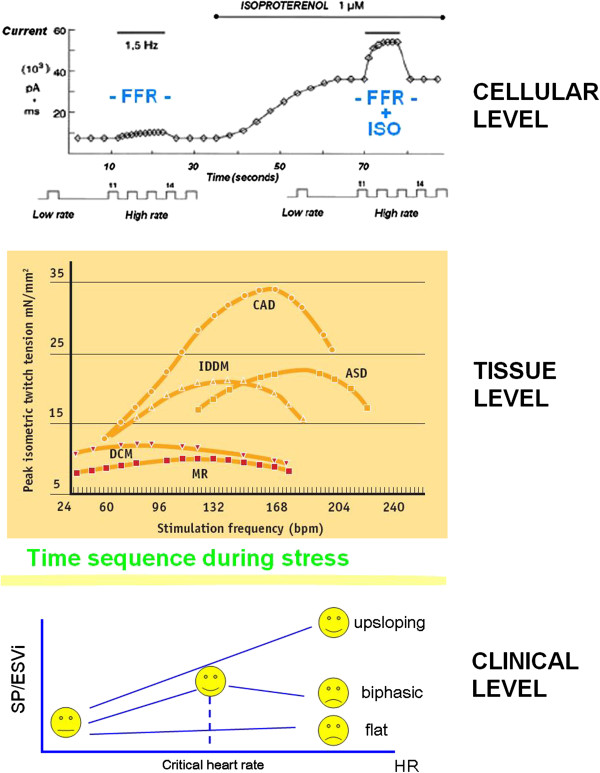
FFR, from myocardial strips to the echo lab. Isolated cardiomyocytes (upper panel): upregulation of Ca2+ entry through Ca2+ channels by high rates of beating is involved in the frequency-dependent regulation of contractility. The effect of increasing contractility by increasing heart rate ("pure" Bowditch treppe) is intrinsic to myocardium and takes a few seconds to occur, while the β-adrenergic amplification of the force-frequency relation (FFR) takes longer, i.e., 30–40 seconds, the time it takes for β-receptor activation and cAMP synthesis (on the right: FFR + ISO). (Modified from: Piot C, Circ 1996 [3]). Middle panel: measurements of twitch tension in isolated left-ventricular strips from explanted cardiomyopathic hearts: the FFR of these failing groups both exhibit a negative treppe at contraction frequencies above about 100 bpm. The contraction frequency at which the FFR begins its descending limb ("optimum stimulation frequency") declines progressively in the order: ASD (atrial septal defect), CAD (coronary artery disease), IDDM (diabetic myopathy), MR (mitral regurgitation), DCM (dilated cardiomyopathy). (Modified from: Mulieri LA. R.A. Howarth Ed. 1997). Lower panel: time sequence during stress echo; the force-frequency relation is built off line. The force-frequency relation is defined as up-sloping when the peak stress systolic pressure/end-systolic volume index (SP/ESV index) is higher than baseline and intermediate stress values; biphasic, with an initial up-sloping followed by a later down-sloping trend, when the peak stress SP/ESV index is lower than intermediate stress values; flat or negative, when the peak stress SP/ESV index is equal to or lower than baseline stress values. The critical heart rate (or optimum stimulation frequency) is the human counterpart of the treppe phenomenon in isolated myocardial strips (Modified from Bombardini T, CU 2005 [1]).